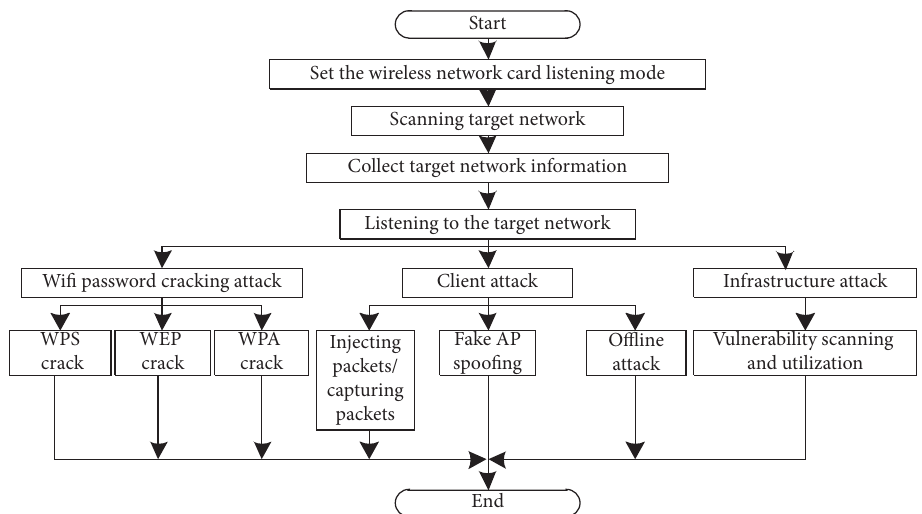
Figure 3: Kali Linux WiFi penetration test’s main technical methods.